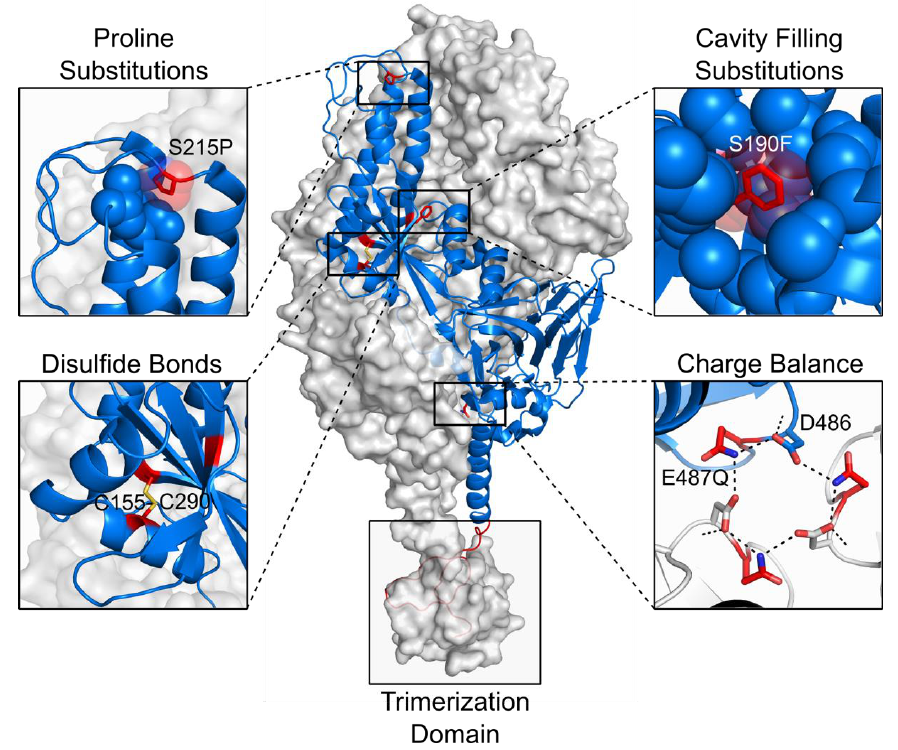
Figure 3. Strategies to stabilize the prefusion conformation of class I fusion proteins. The protein shown corresponds to the trimeric RSV F protein (PDB 4MMV and 5C6B) with two protomers as grey molecular surfaces and one protomer as a blue ribbon. Stabilizing substitutions (S215P, S190F, S155C, S290C, Q487, and a foldon domain) are presented in red, and hydrogen bonds are depicted as black dotted lines. Each panel contains an example of the main stabilization strategies of the prefusion conformation.